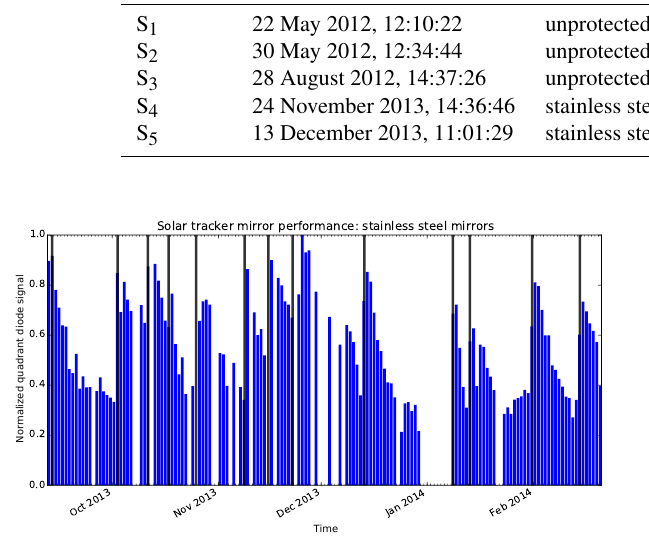
Figure 10. Reflectance over time for the first set of stainless mirrors (MPI-BGC). Like in Fig. 4, the red vertical lines indicate when the mirrors were